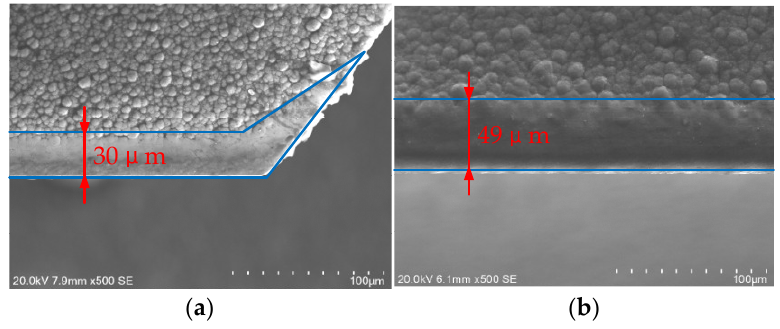
Figure 3. The tool wear morphology when the milling length was 12 m, ( a ) the tool wear morphology of the rhombic milling cutter and ( b ) the tool wear morphology of the staggered helical milling cutter.